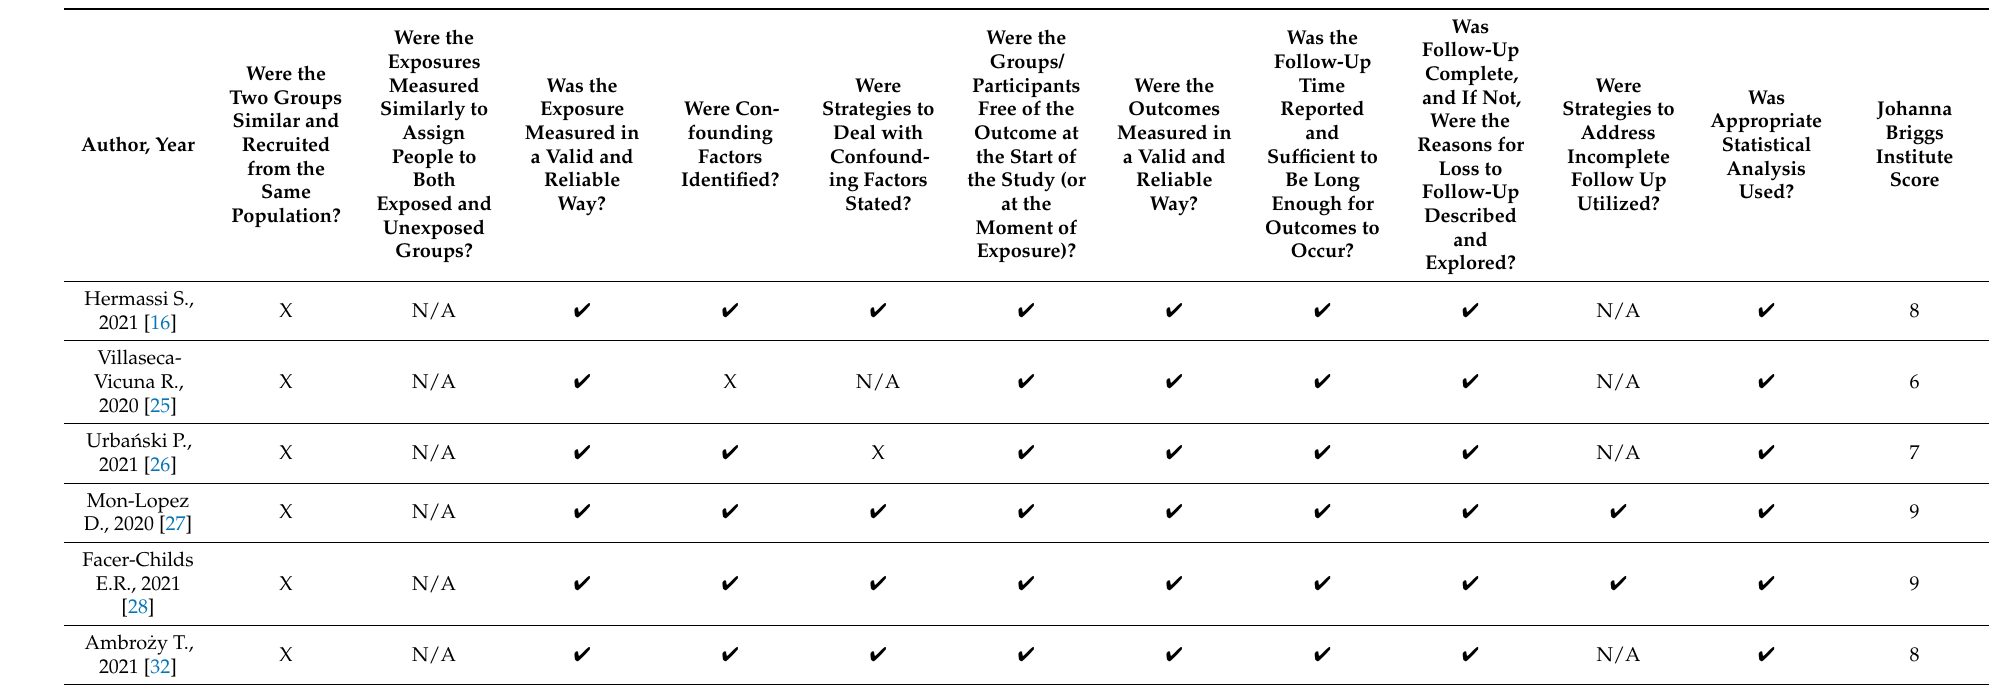
Table 5. Critical appraisal of cohort